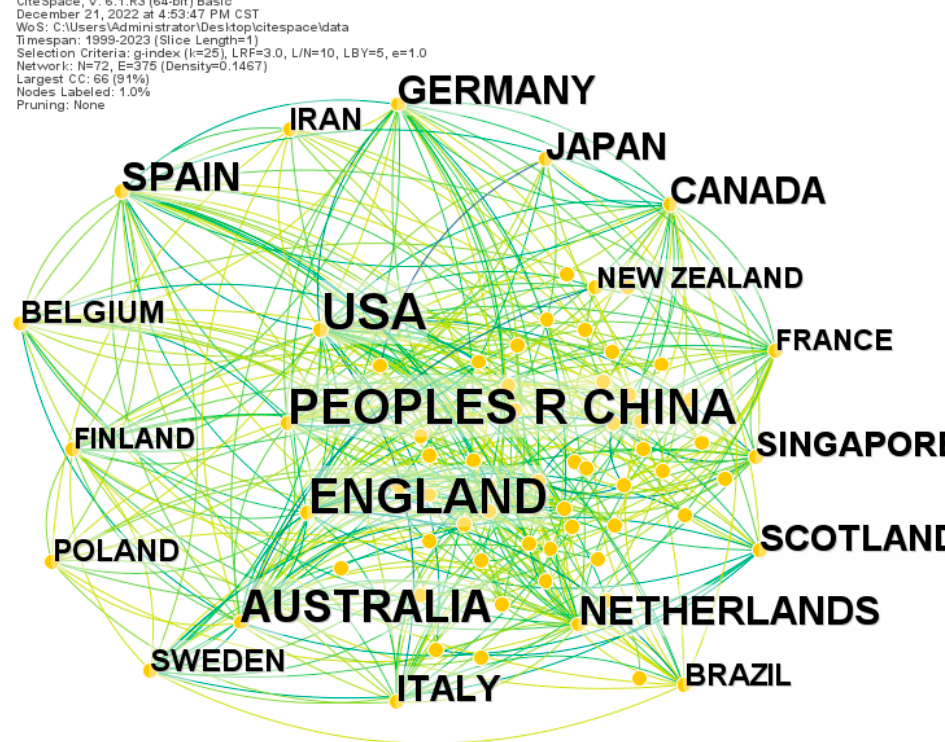
Figure 3. The geographical distribution and co-citation network for the study of green space and senior mental health. Note: The size of the label font in the figure represents the number of published documents, and the link between nodes represents the cooperative relationship between countries/regions.